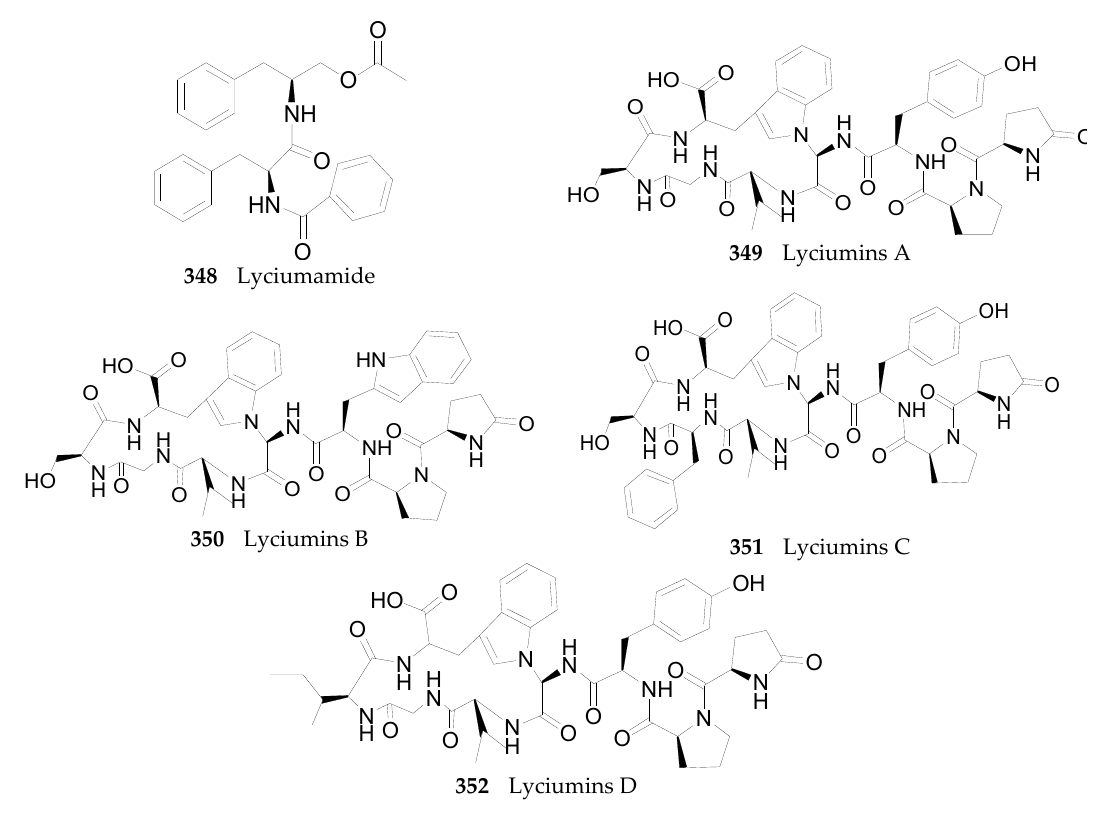
Figure 23. Chemical structures of compounds 348 – 352 .